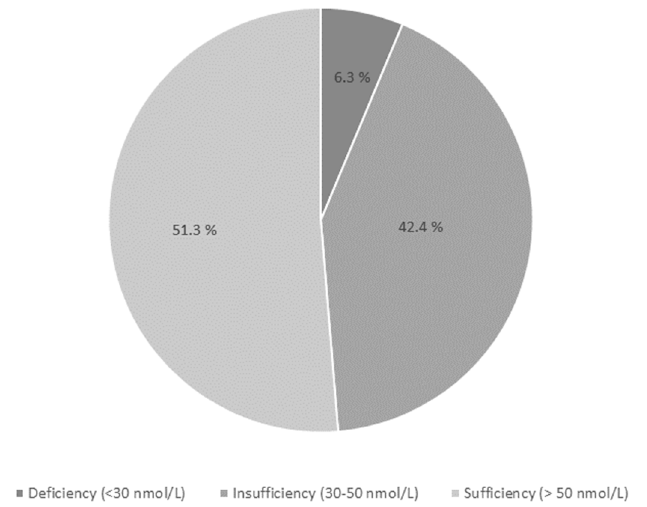
Figure 1. Vitamin D status in the study population. Table 2. Prevalence of hypovitaminosis D by sociodemographic and lifestyle